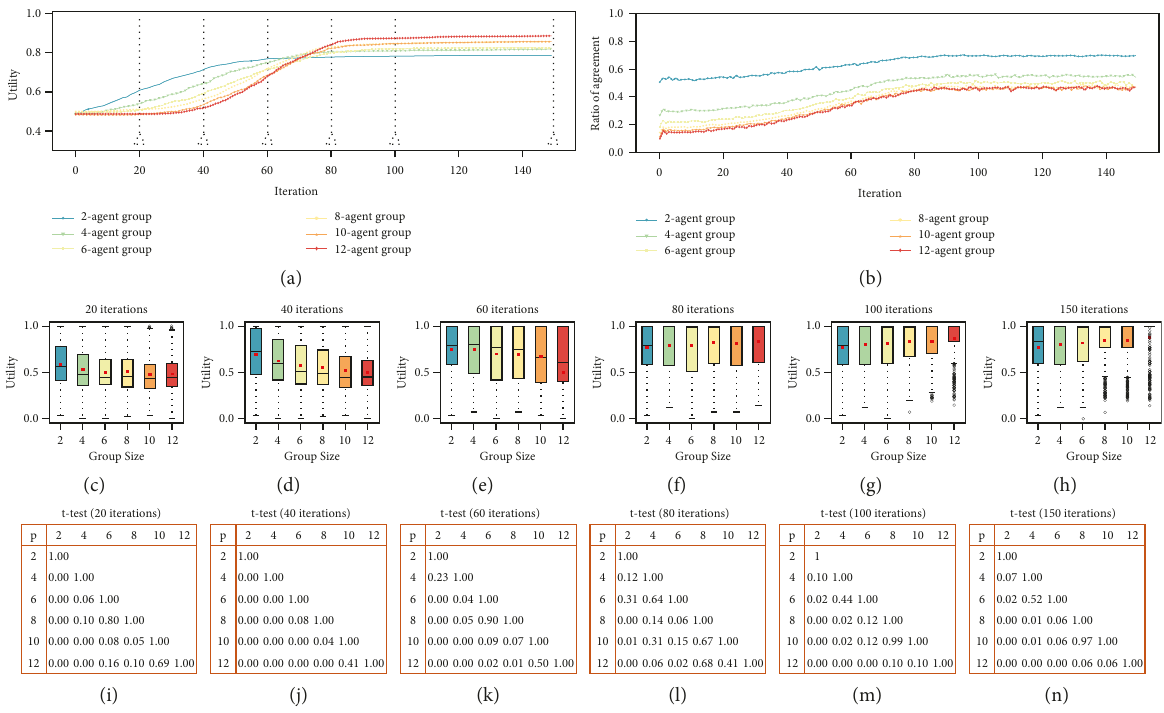
Figure 6: Change of utility of group solution (500 independent Monte Carlo experiments) and the ratio of agreement (500 independent Monte Carlo experiments) over iteration (discussion time) on 4-peak problem space.